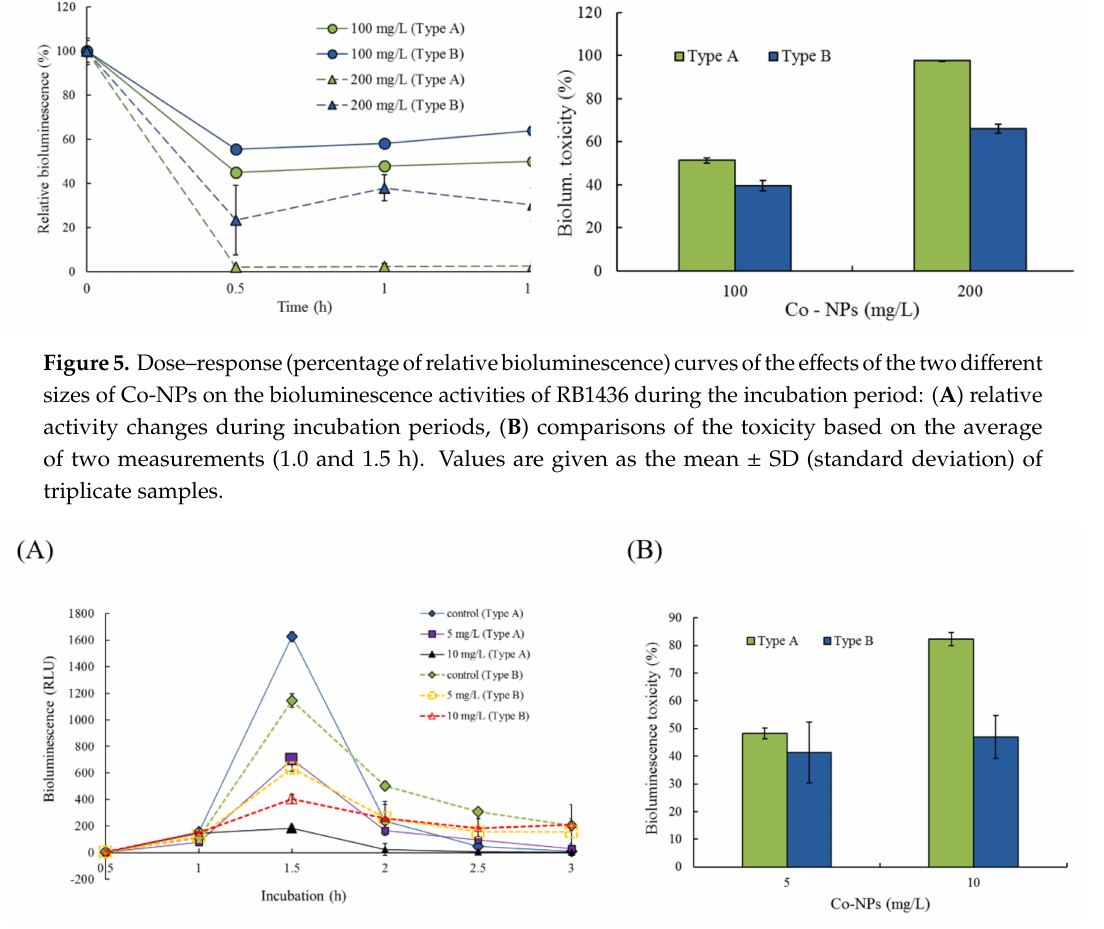
Figure 6. Comparisons of the e ff ects of the bioluminescence activity of bioreporter strain KG1206 in the presence of the two di ff erent sizes of Co-NPs with inducer o -chlorotoluene (final concentration 1 mM): ( A ) changes in bioluminescence activity by incubation time, ( B ) comparison of the toxic e ff ects on the bioluminescence